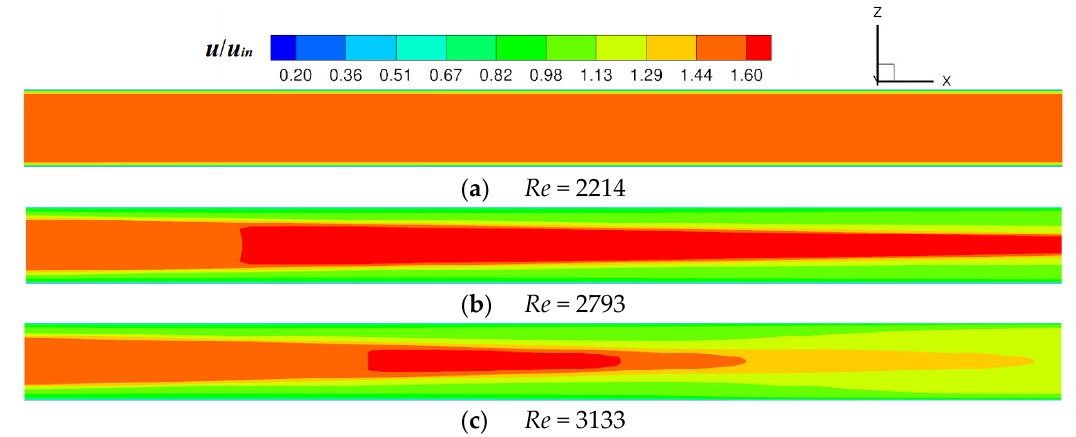
Figure 10. Nusselt number contours on the primary wall.